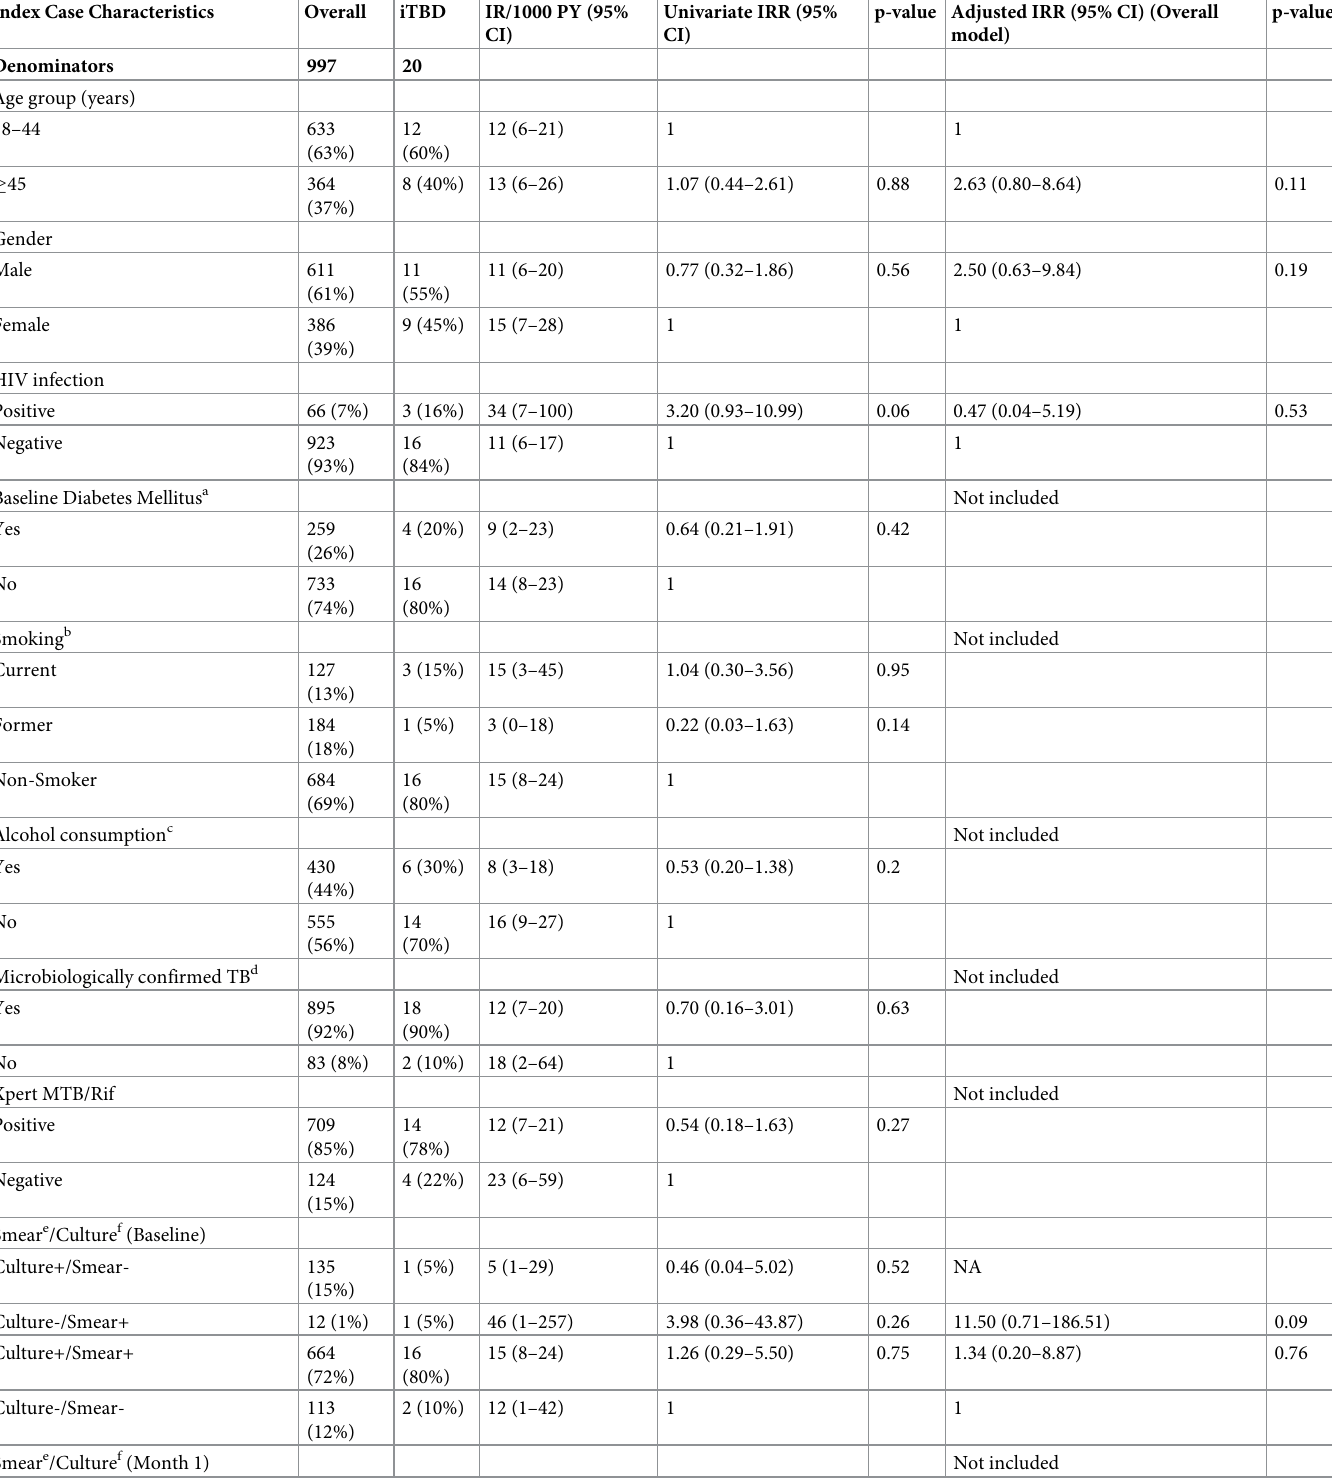
Table 2. Baseline characteristics of pulmonary TB index patients and risk factors for incident TB disease among household contacts of adult pulmonary TB patients in